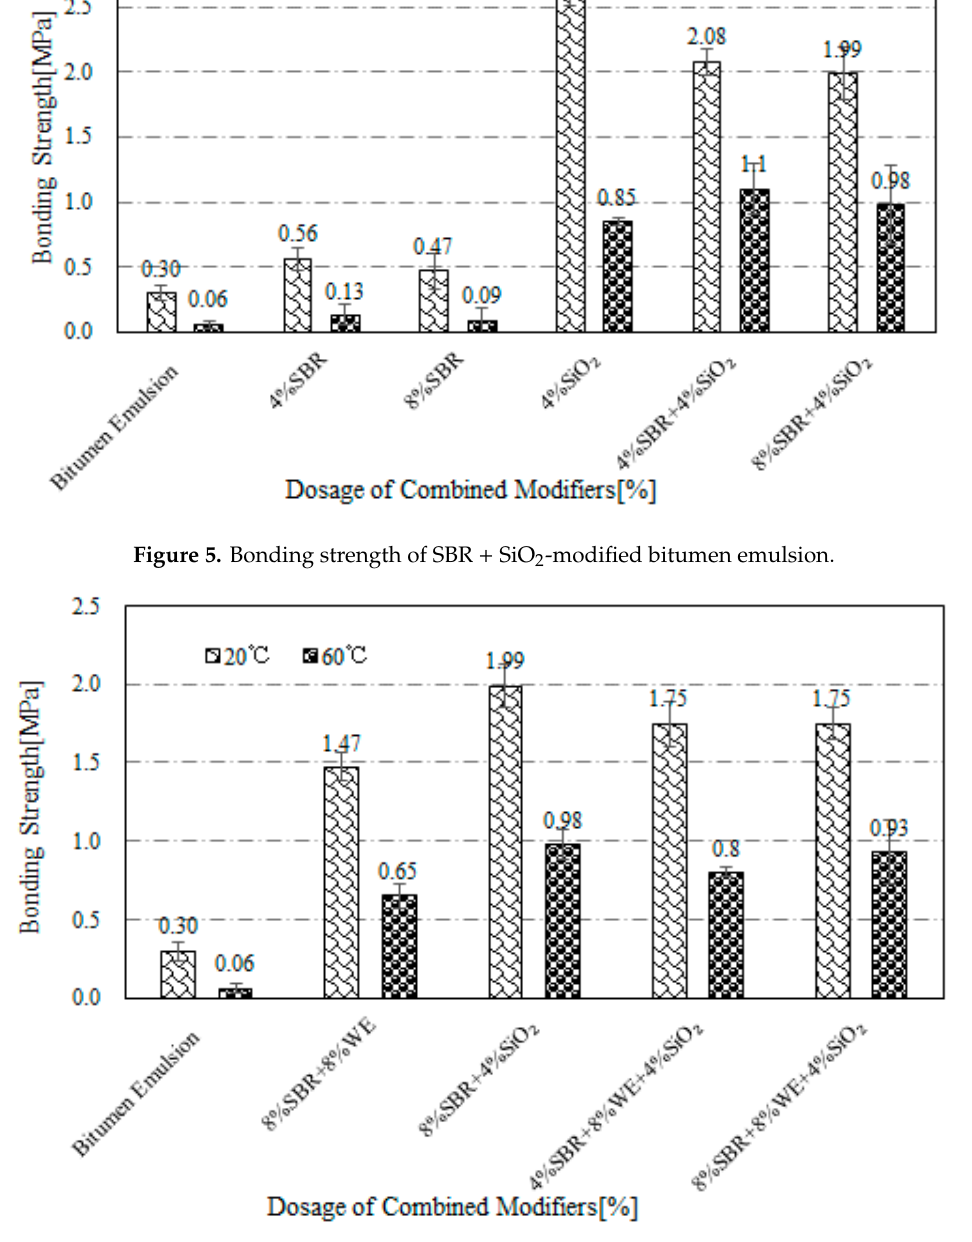
Figure 6. Bonding strength of SBR + WE + SiO 2 -modified bitumen emulsion.